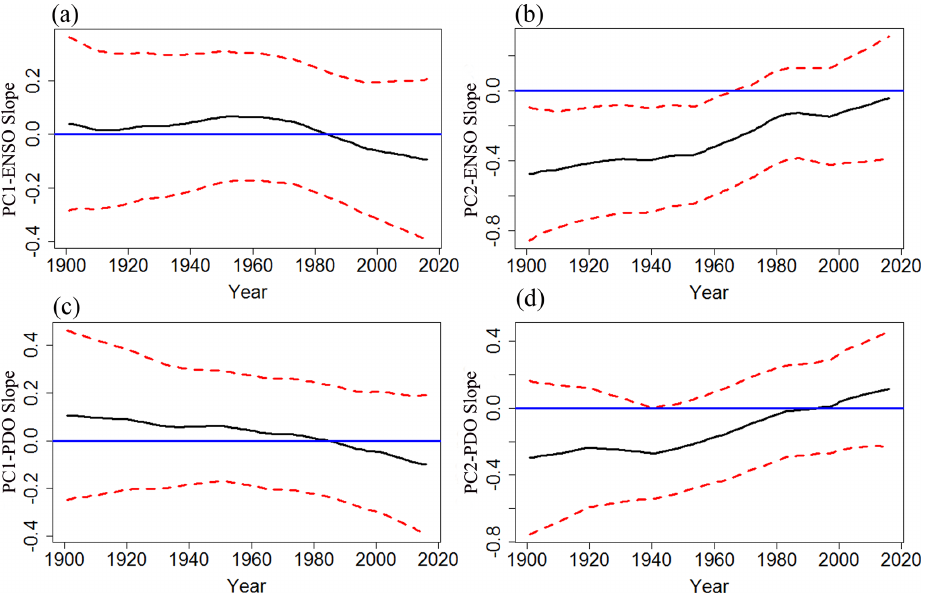
Figure 13. Changes in the relationships between rainfall and the ENSO/PDO over time from 1901–2015. Black solid lines denote the estimated time-varying slopes, along with the 25th and 75th percentile credible interval lines (red dotted lines) from the Bayesian dynamic linear model